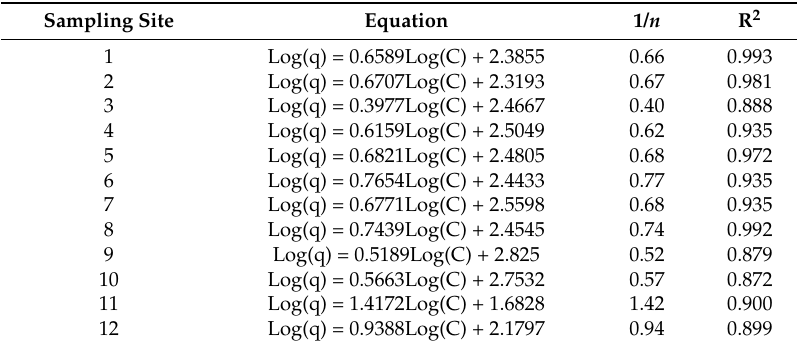
Table 4. Fitting model of